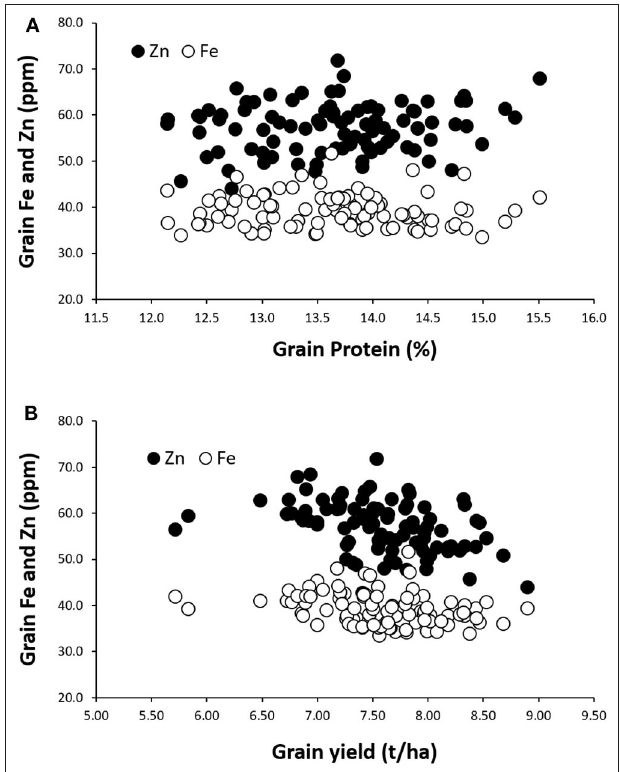
FIGURE 2 | Relationships between grain Zn and Fe concentrations and grain protein content (A) and grain yield (B) among the 94 lines grown either during the 2018 or 2019 crop